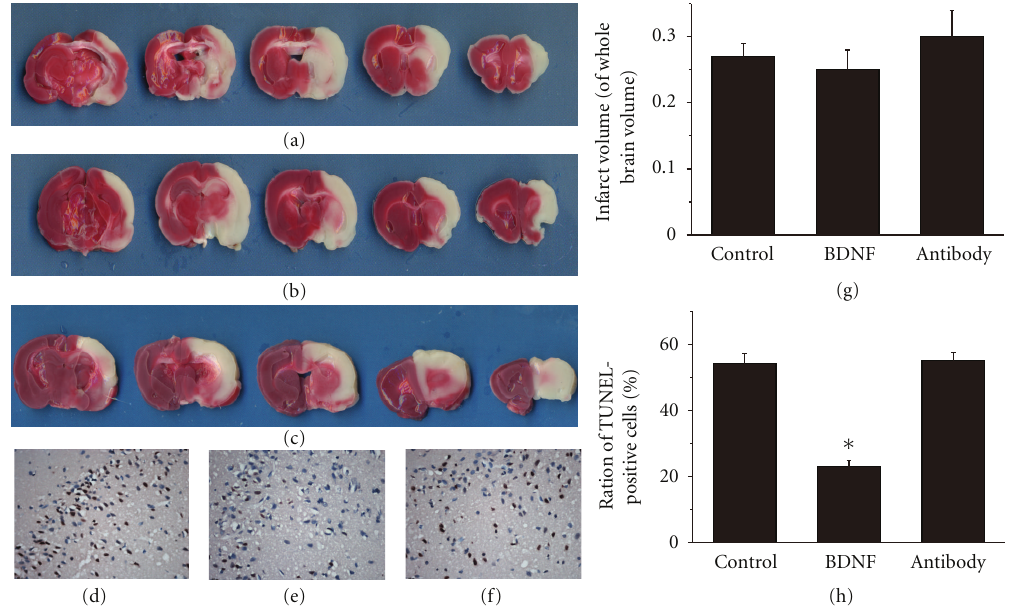
Figure 2: BDNF alleviated cellular injury of ischemic insult brain tissue sections obtained from injured cerebral hemispheres were stained with triphenyltetrazolium chloride (TTC) and TUNEL assay 24h after reperfusion. (a) Infarct volume without any treatment. (b) Infarct volume with exogenous BDNF. (c) Infarct volume with exogenous BDNF antibody. (d) TUNEL assay in control group. (e) TUNEL assay in BDNF group. (f) TUNEL assay in antibody group. (g) No significant di ff erence of infarct volume in the three groups. (h) Summary of TUNEL-positive cells 24h after ischemia. Scar bar: 100 μ m. Bars represent mean ± SD ( n = 6); ∗ P < . 05 versus control